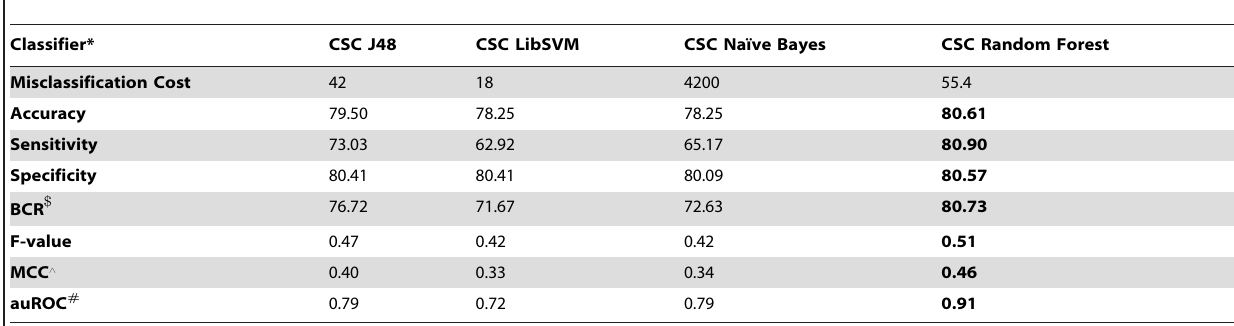
Table 4. Statistics of best predictive models generated by 10 fold cross-validation of training dataset.